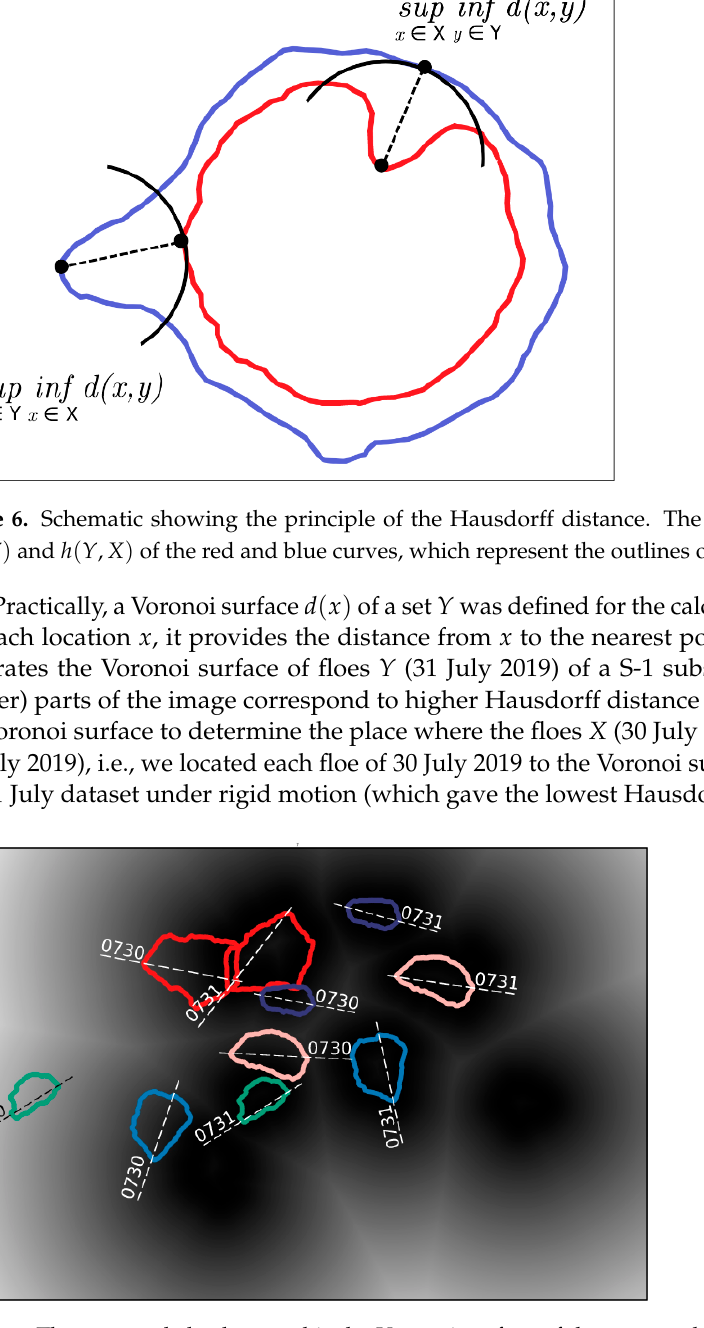
Figure 7. The grey scale background is the Voronoi surface of the extracted floes of an S-1 subset from 31 July; floes are labelled by date. The same color refers to same floe at different dates.